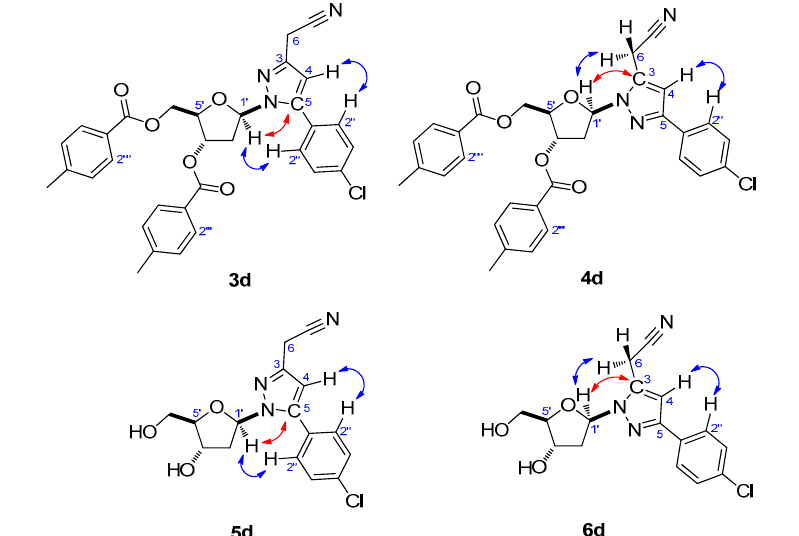
Molecules 2019 , 24 , 3922 Table 4. Results from the NOESY and HMBC spectra of the pairs 3d – 4d and 5d – 6d *.